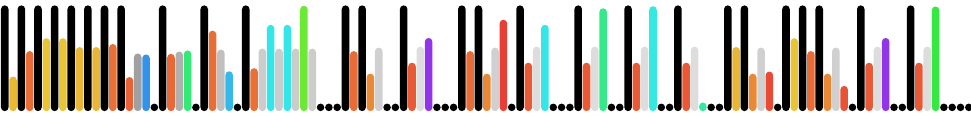
Figure 14. Visualization of Clapping Music encoded genotype. The decoded genotype shown in Listing 1 was encoded as a float array as described in Figure 6. The visualization of this numeric sequence, using the color code detailed in Table 2, shows that most of the code consists of genotype functions (introduced and closed by black long and short bars), while there are only a few leaf values (numeric values given as final parameters, preceded by gray bars). As discussed previously, this vector is also one of its related germinal vectors.